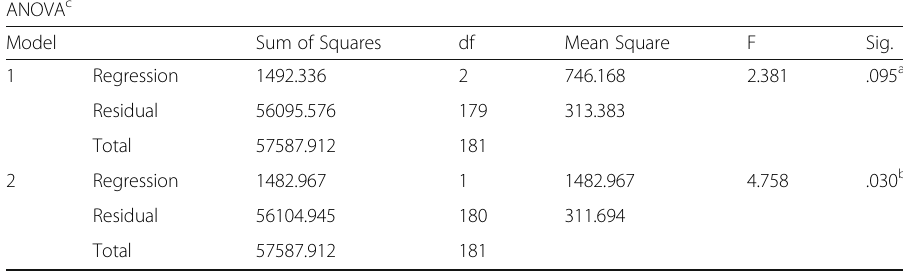
c Dependent Variable: foreign language